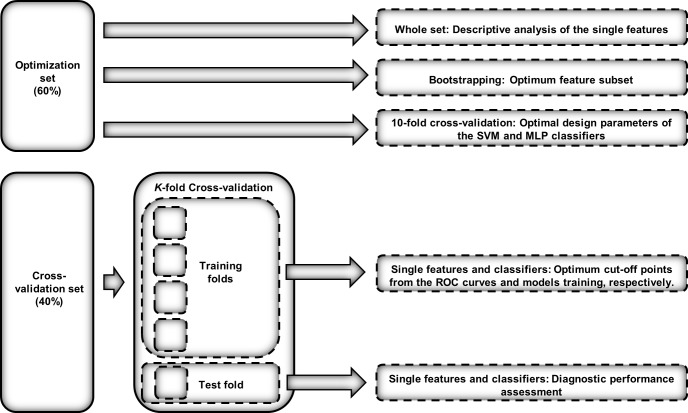
Validation approach employed in each methodological step of the study.